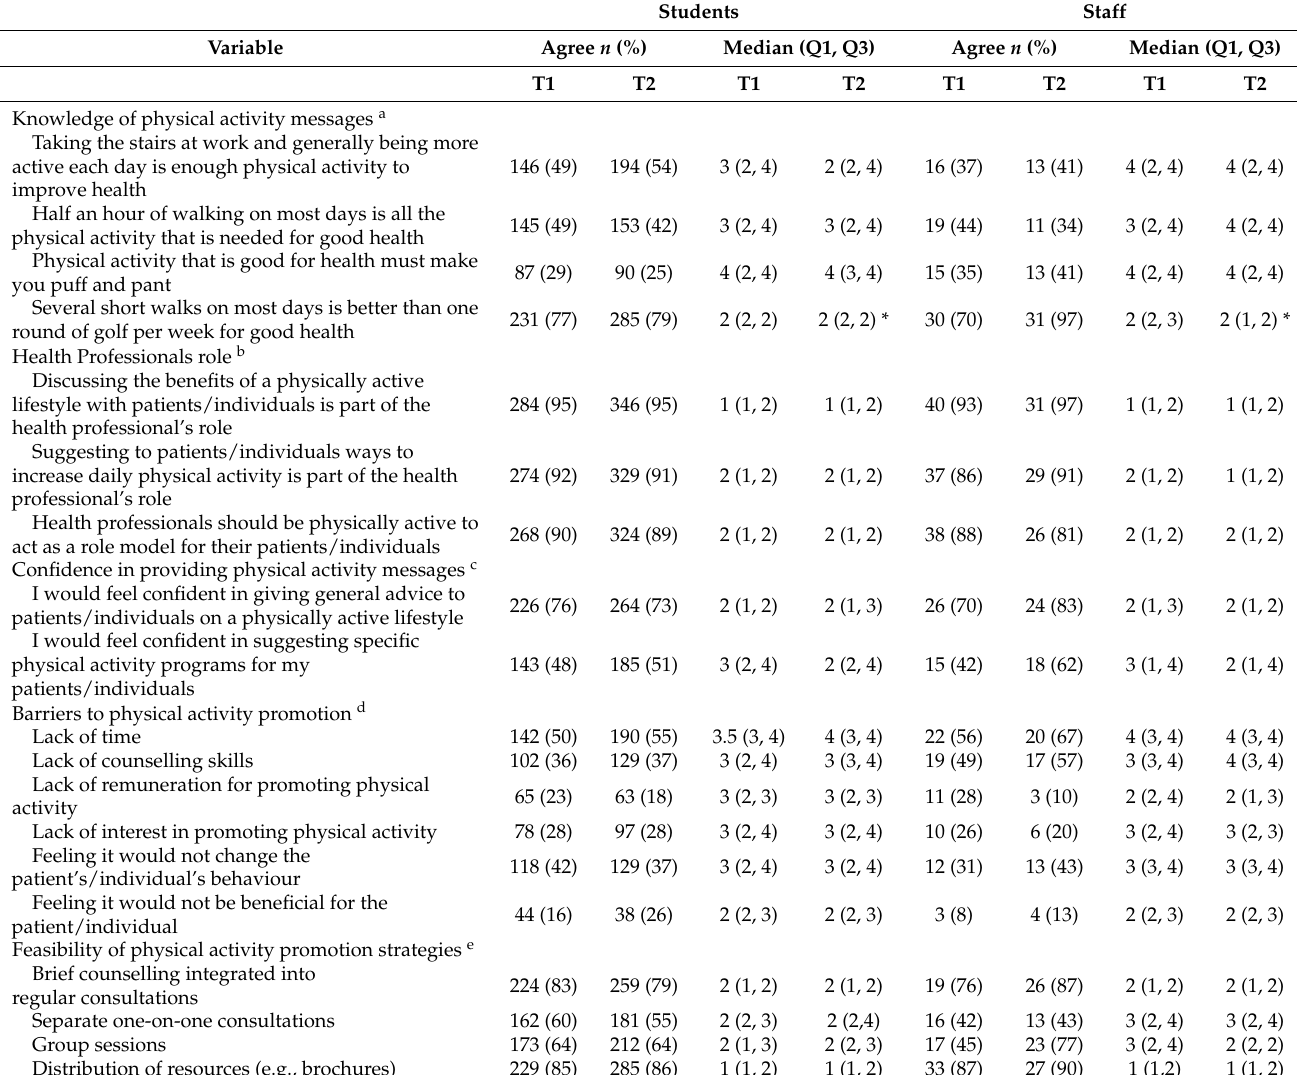
Table 2. Health students and staff knowledge, role perception, confidence, feasibility, and barriers in relation to physical activity promotion pre- and post-intervention. Students Staff Variable Agree n (%) Median (Q1, Q3) Agree n